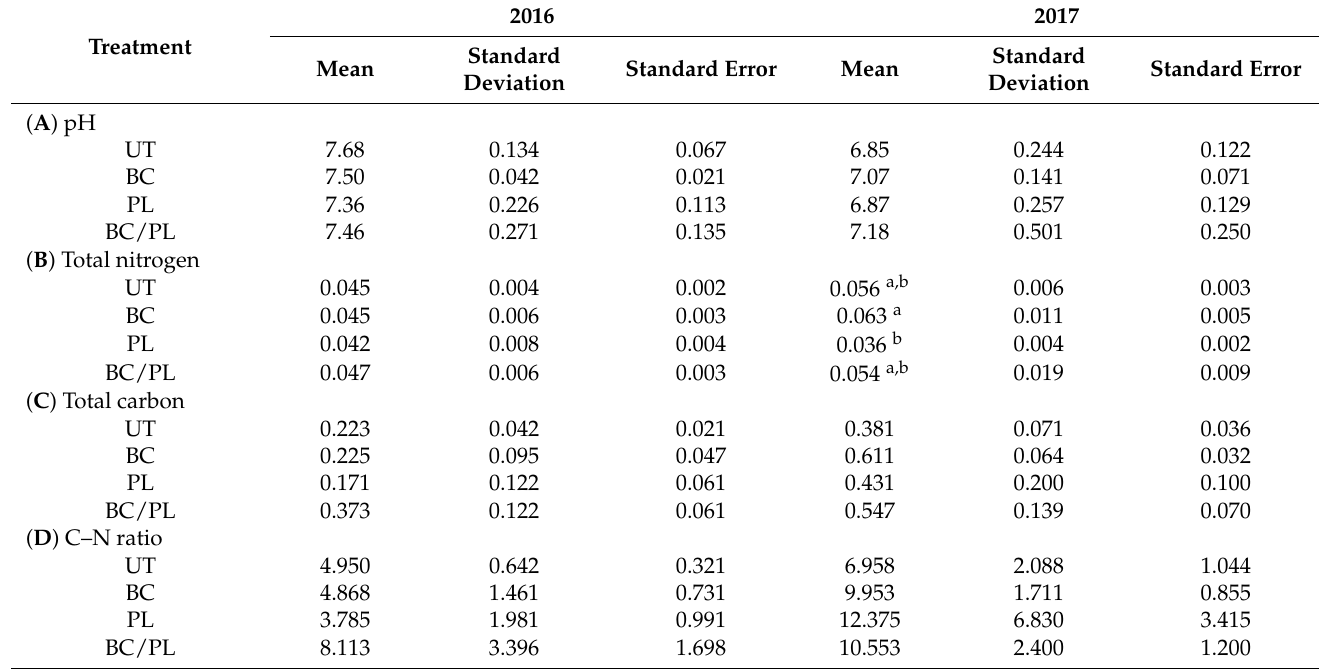
Table 6. Soil chemical data in 2016 and 2017 for pH, total nitrogen, total carbon, and carbon/nitrogen ratio.